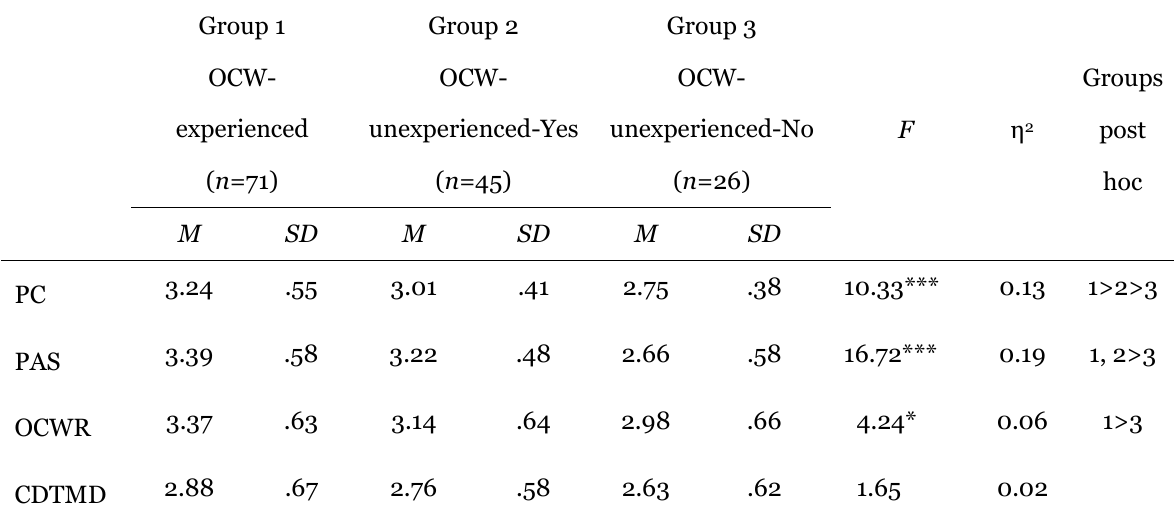
Descriptive Statistics and One-Way MANOVA Results for Different Groups on TRS-OCW